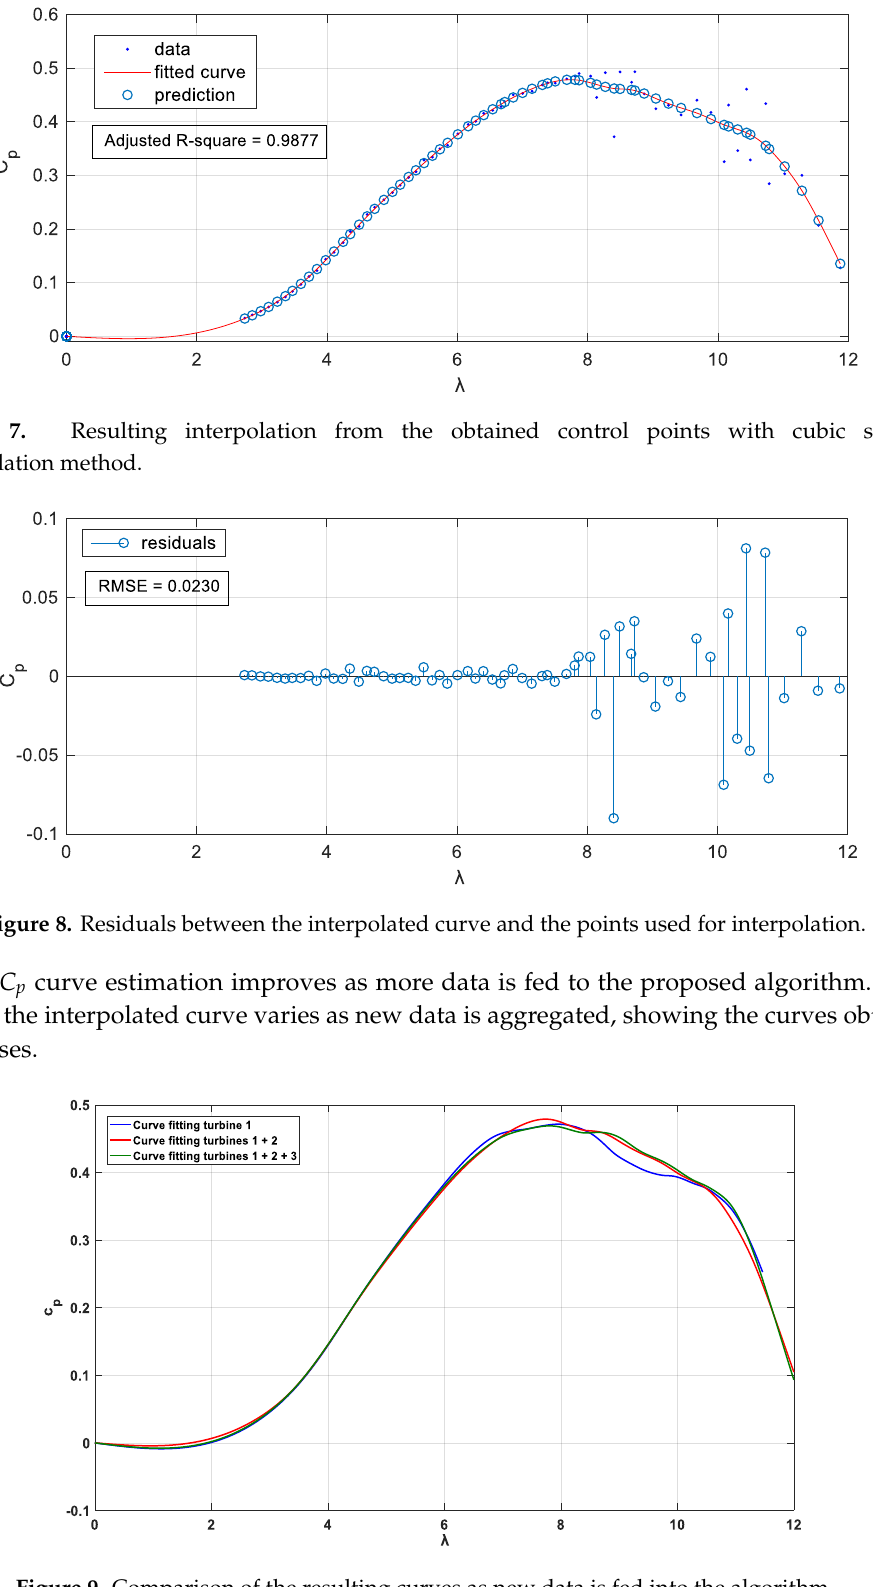
Figure 9. Comparison of the resulting curves as new data is fed into the algorithm.